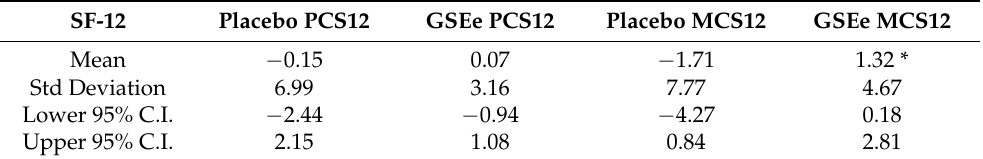
Table 4. Descriptive statistics of delta MCS12 and PCS12 score between end of intervention and